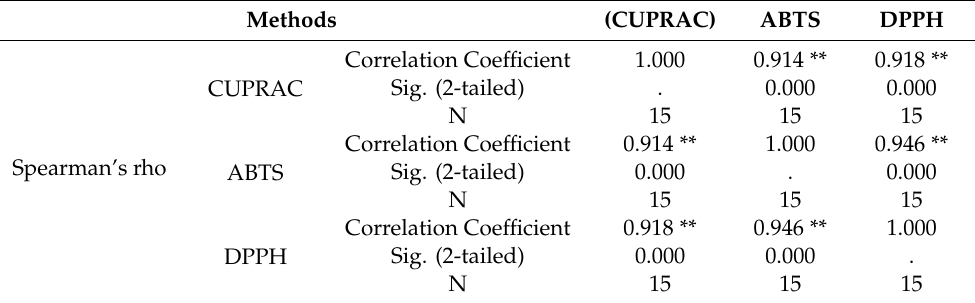
Table 2. Spearman’s rank correlation coefficient for antioxidant methods.